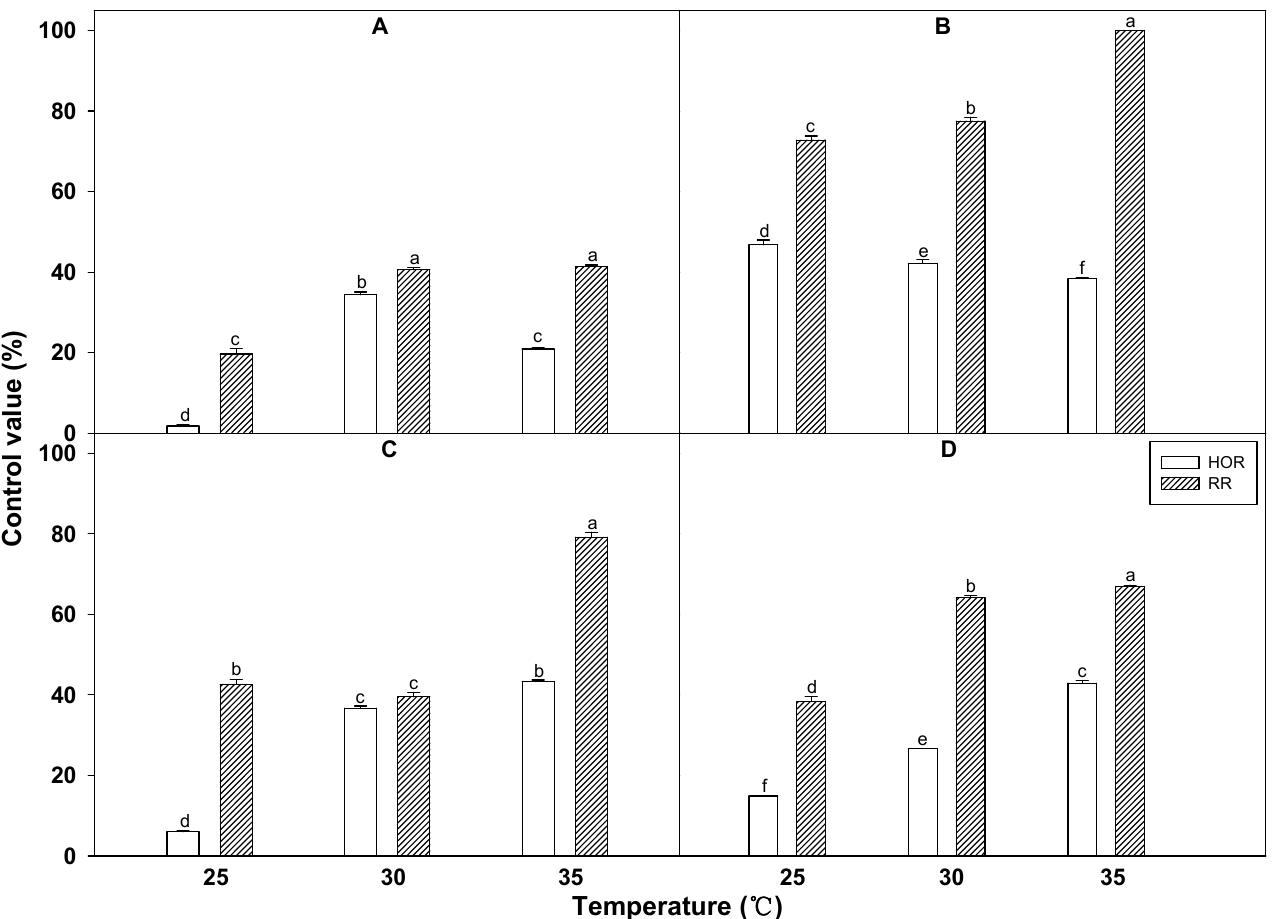
Figure 7. Control value (%) of A. patulus in response to soil-applied herbicides ( A . alachlor; B . metolachlor; C . ethalfluralin; D . linuron) at different growth chamber temperatures. HOR: Half of the recommended rate; RR: Recommended rate. Means within bars followed by the same letters are not significantly different at the 5% level according to Duncan’s Multiple Range Test. Error bars represent SE.